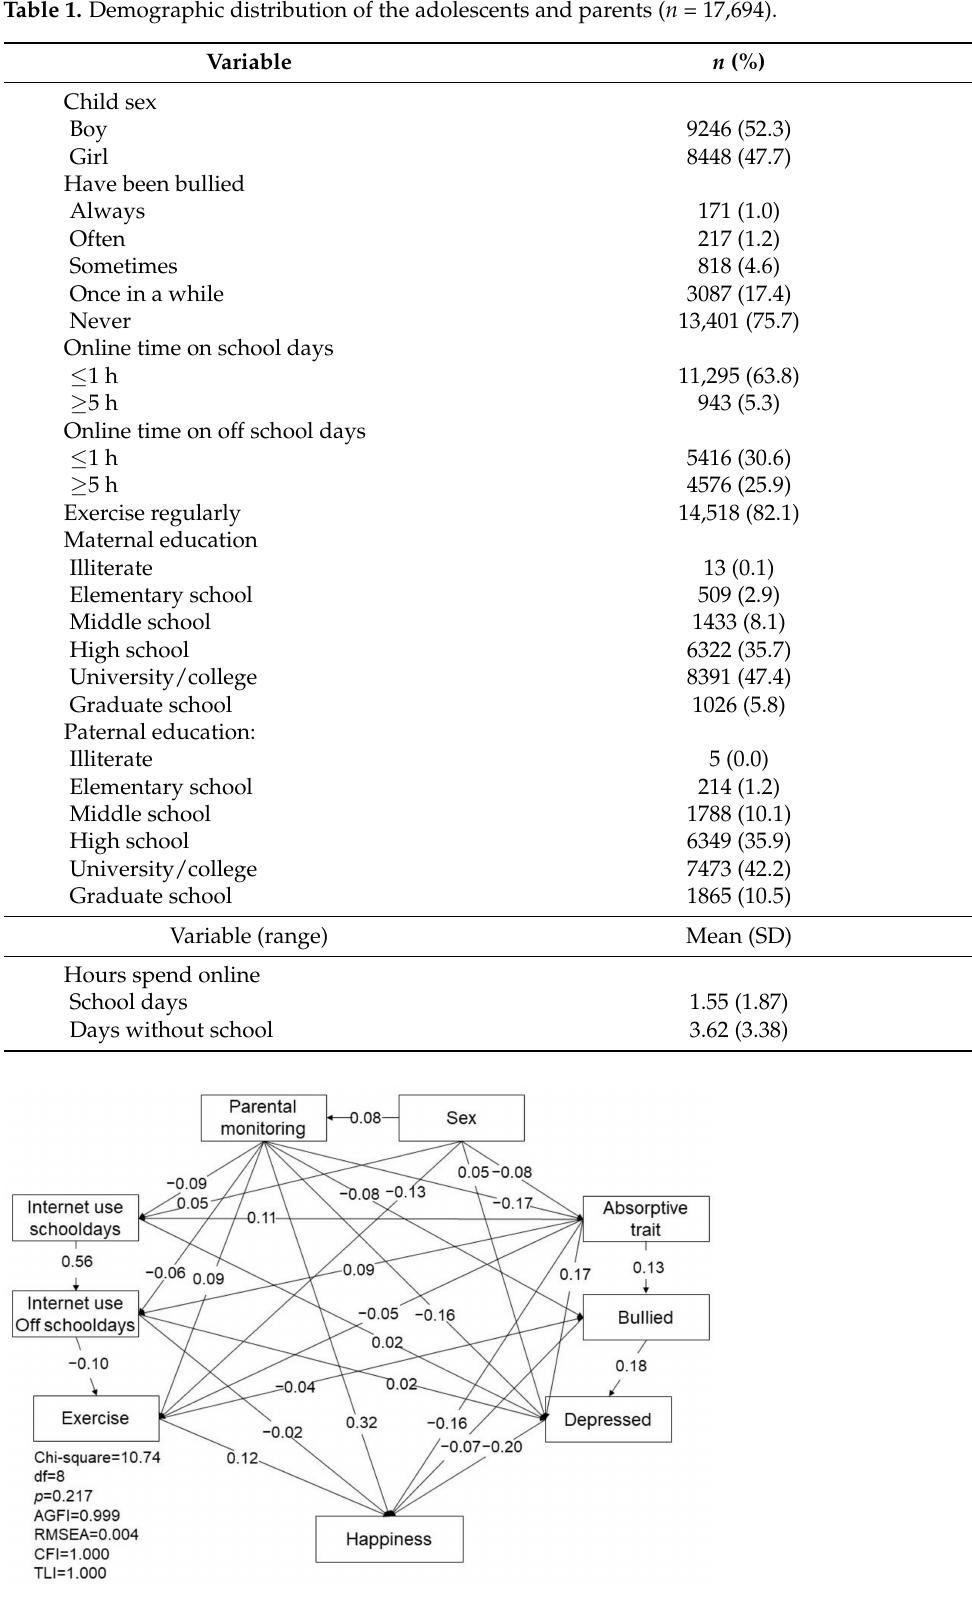
Figure 1. The path relationships among dissociative trait, bullying, internet use, depressive mood, and happiness in 12-year-olds. AGFI: adjusted goodness-of-fit; RMSEA: root mean square error of approximation; CFI: comparative fit index; TLI: comparative fit